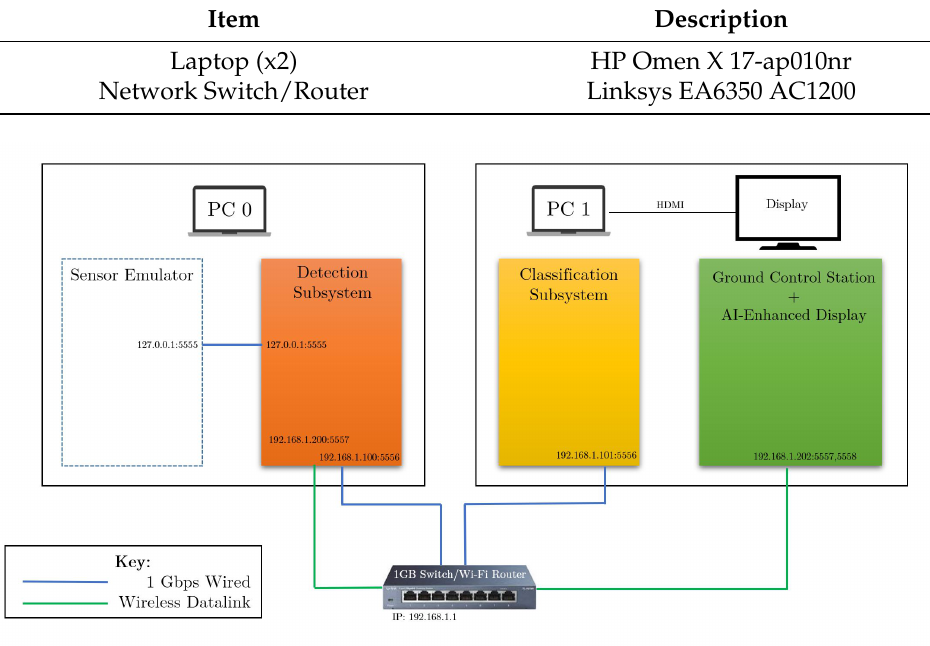
Figure 3. Prototype network